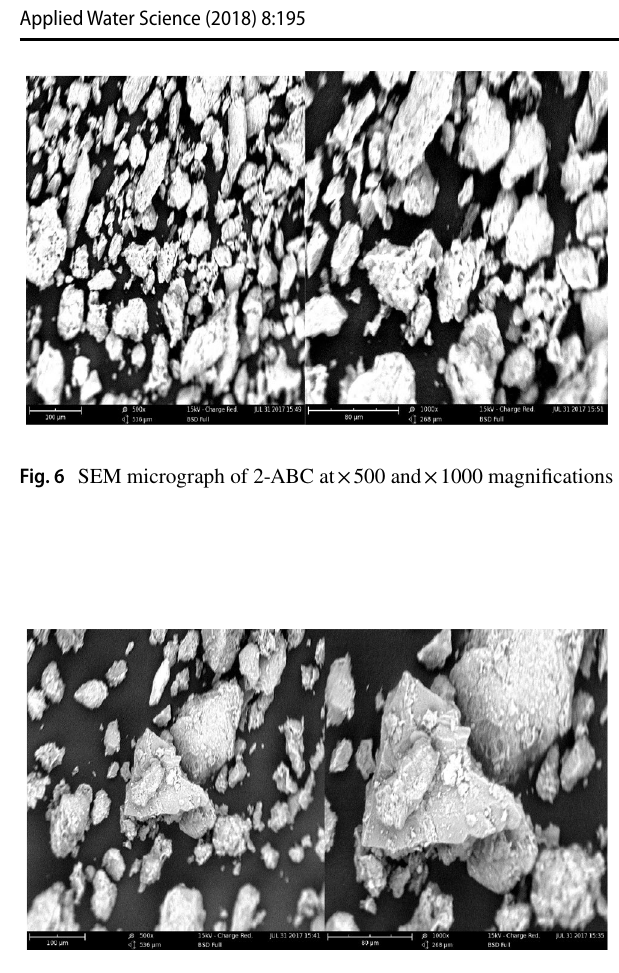
Fig. 7 SEM micrograph of 2-BBC at × 500 and × 1000 magnifications